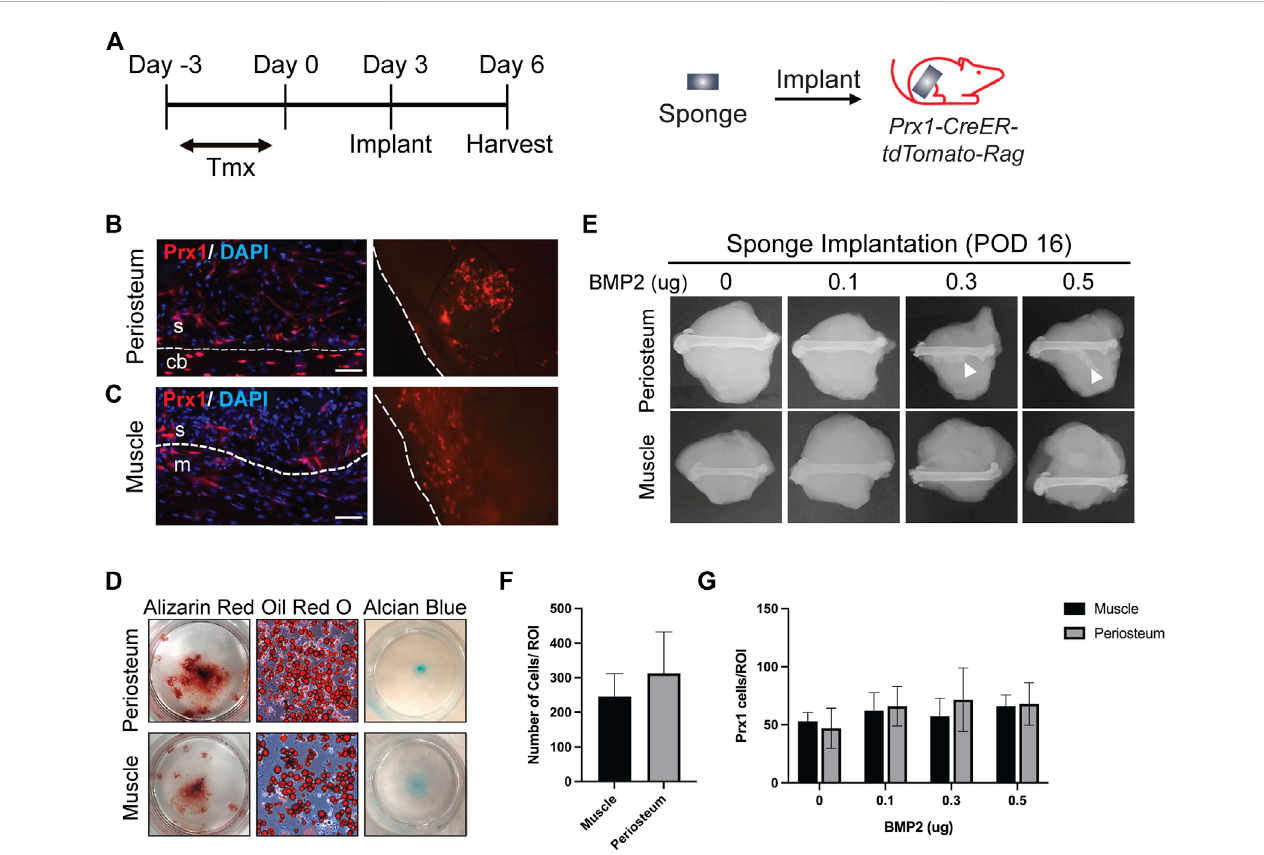
FIGURE 1 Site Speci fi c Stem Cell Retrieval for In vitro and In Vivo Assessment of Differentiation Potential (A) . Schematic representation of sponge implantation in hindlimbs of Prx1-CreER-tdTomato-Rag donor mice. (B – C) . Prx1-tdTomato expression in gelatin sponges that were implanted on the periosteum surface (B) or intramusclar pouch (C) of Prx1CreER-GFP/Ai14/Rag1 mice. Sponges were harvested after 3 days of implantation. The left images are representative IF staining of the sponges along with surrounding tissues. Right images show tdTomato expression in the sponge that were directly examined under the fl uorescent microscope. The sponges are outlined by the dashed lines. Red: tdTomato, blue: DAPI. S = sponge; cb = cortical bone; m = muscle. Scale bars = 50 µm. (D) Representative images of in vitro differentiation of cells isolated from the sponges implanted on the periosteum or muscle. Cells were cultured in osteogenic, adipogenic, and chondrogenic inducing media to determine differentiation potential. Shown by alizarin red S (osteogenic), Oil red O (Adipogenic), and alcian blue (chondrogenic) staining. (E) . Plain fi lm radiography of sponges implanted on the periosteal surface or in the intramuscular pouch of the femur, supplemented with various amount (0 – 0.5 µg) of BMP2. Sponges were harvested at post-implantation day 16, only the periosteum implants with higher concentration of BMP2 (0.3 μ g and 0.5 μ g) induced ectopic bone (white arrowhead). (F) . Quanti fi cation of total cells in the sponges from muscle and periosteum. (G) . Quanti fi cation of Prx1-derived cells tagged with tdTomato in the sponges from muscle and periosteum supplemented with various amount (0 – 0.5 µg) of BMP2. Data are mean ± s.d.; 3-4 independent